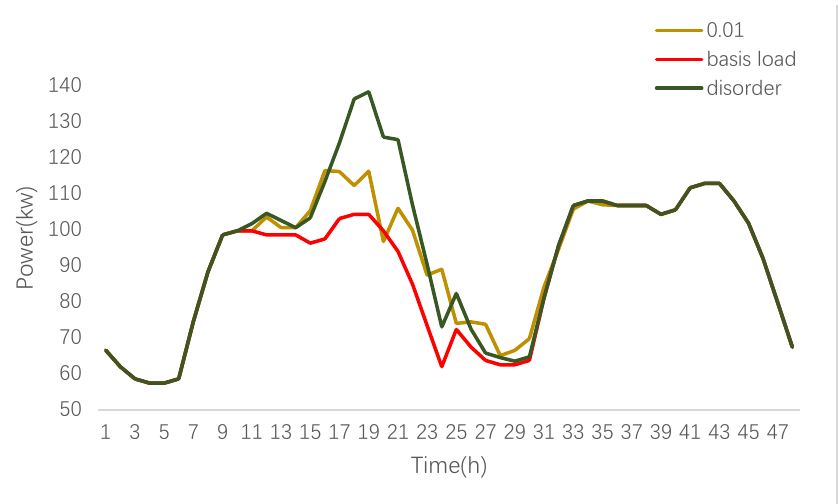
Figure 7. Optimization results were compared with disordered charging.